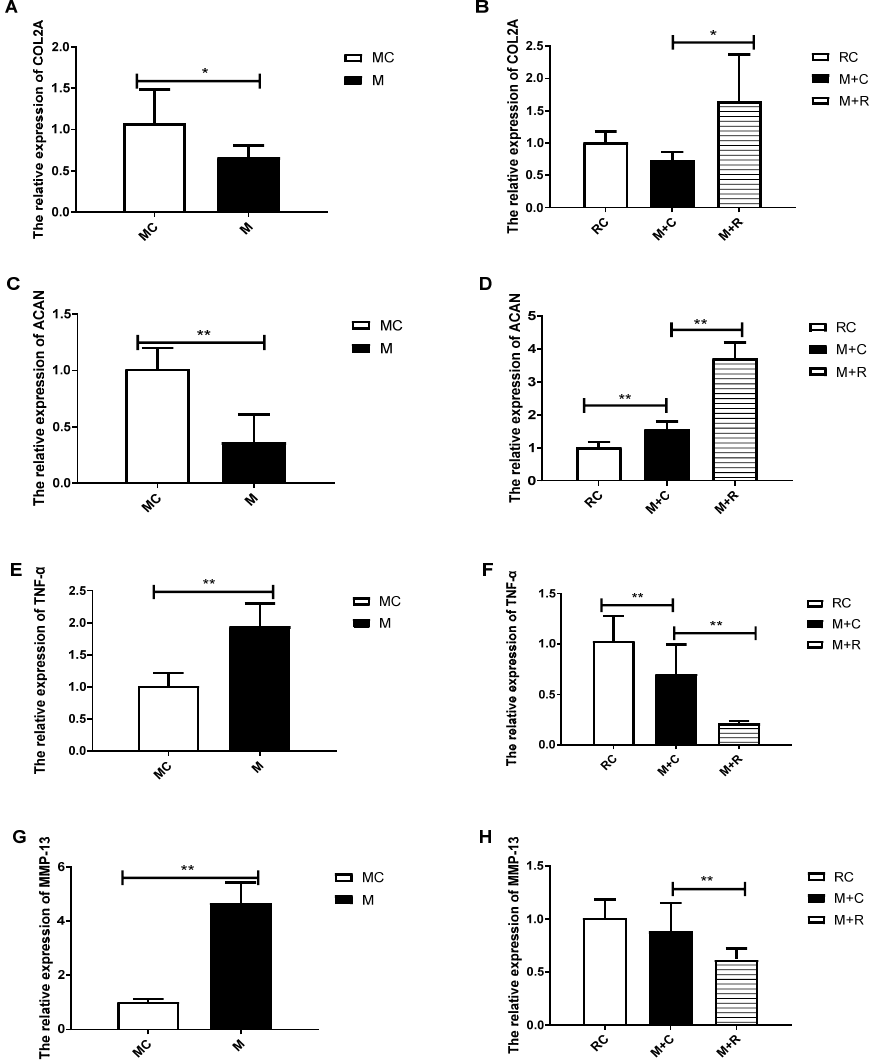
Figure 4. The gene expression of metabolic and inflammatory factors of knee joint cartilage. ( A , B ) the expression of COL2A mRNA; ( C , D ) the expression of ACAN mRNA; ( E , F ) the expression of TNF- α mRNA; ( G , H ) the expression of MMP-13 mRNA (n = 8, * p < 0.05, ** p < 0.01.)